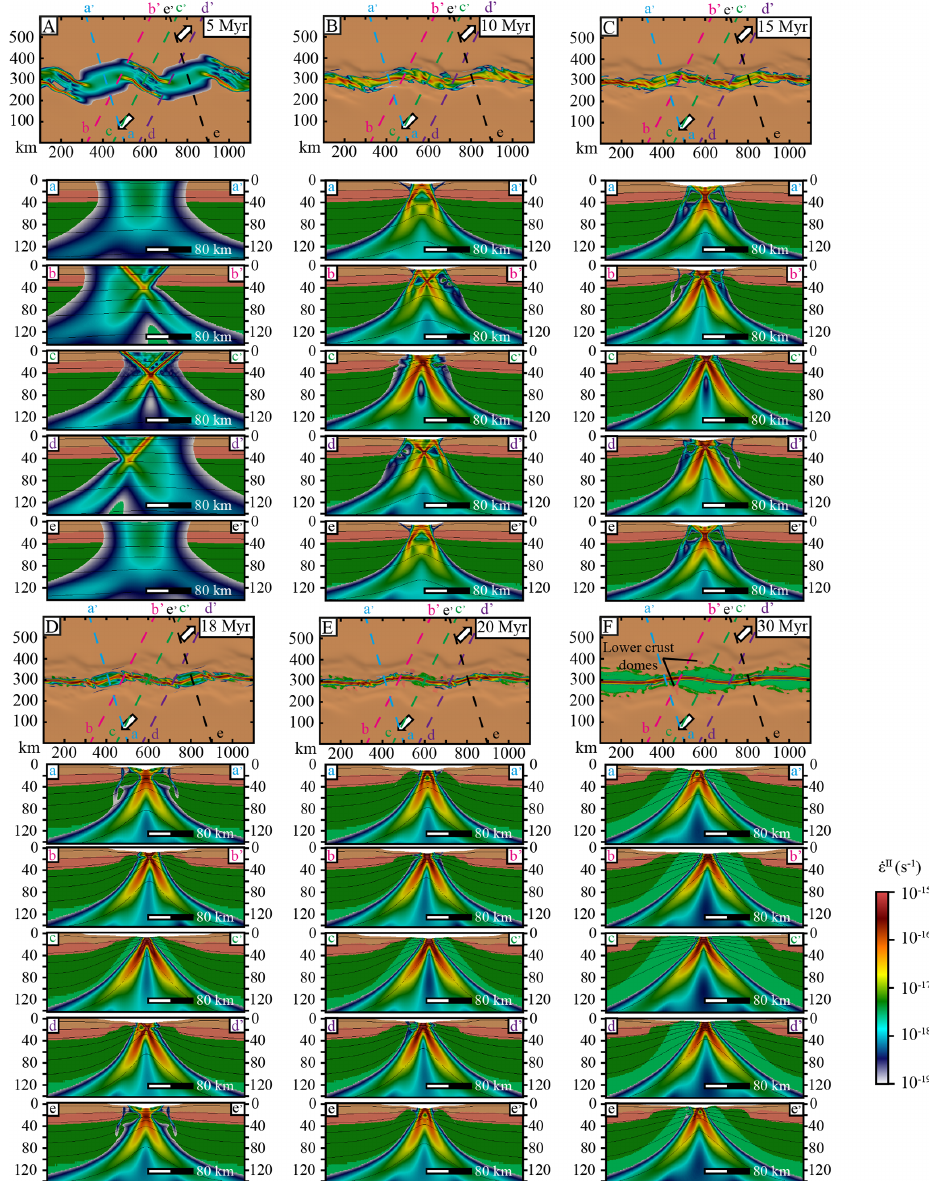
Figure 6. Model 2, strong lower crust, α = 45 ◦ . Map views and cross sections of simulated lithologies and second invariant of the strain rate tensor (Eq.